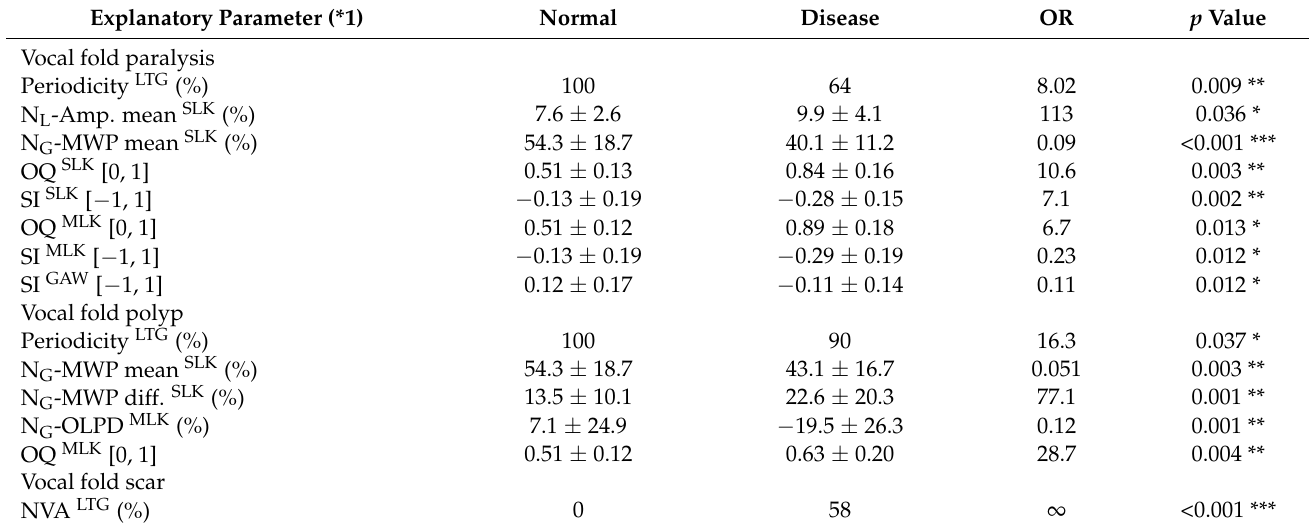
Table 8. Key parameters of vocal fold paralysis, polyp, and scarring.